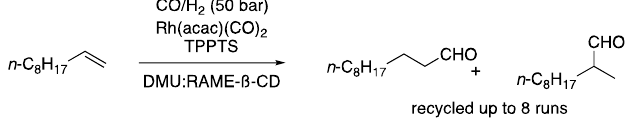
Figure 3. Hydroformylation of 1-decene.